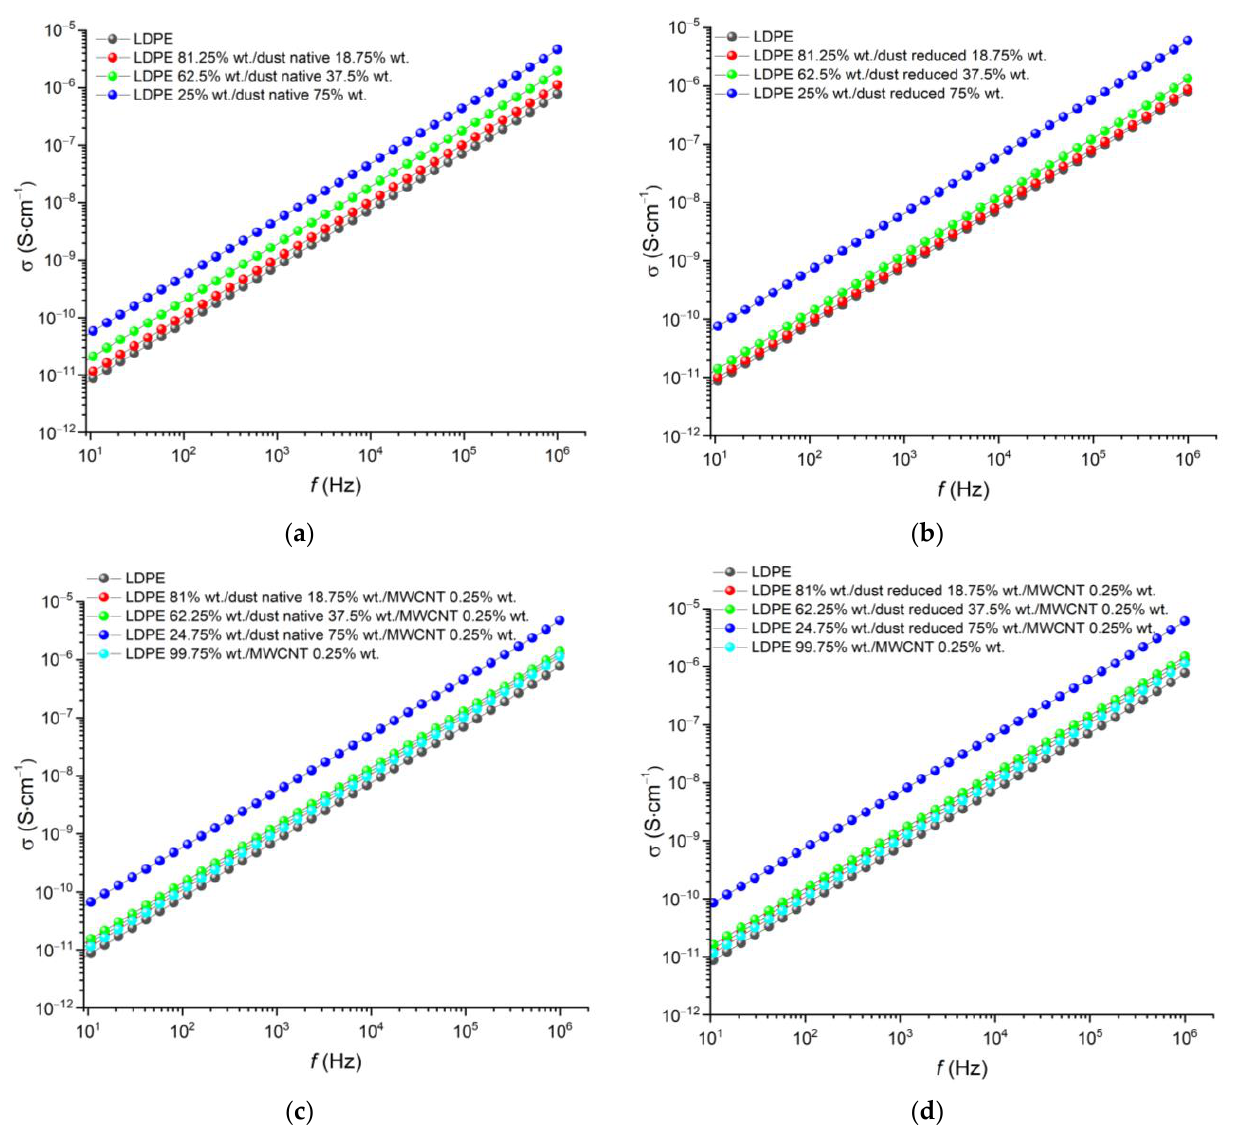
Figure 6. The frequency dependence of conductivity of composite films based on LDPE filled with ( a ) native dust, ( b ) reduced dust, ( c ) native dust/MWCNT, and ( d ) reduced dust/MWCNT.